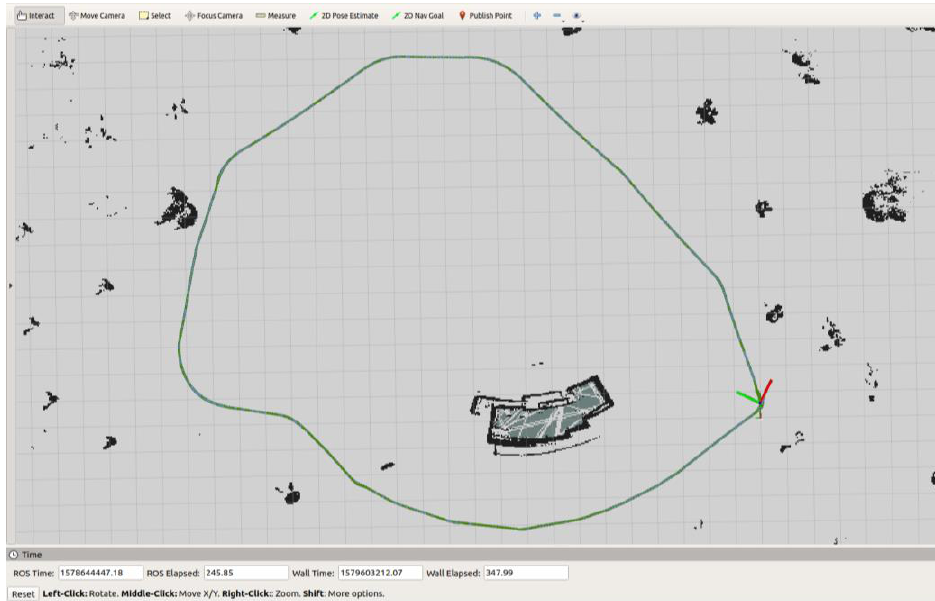
Figure 10. Practical localization performance on map.